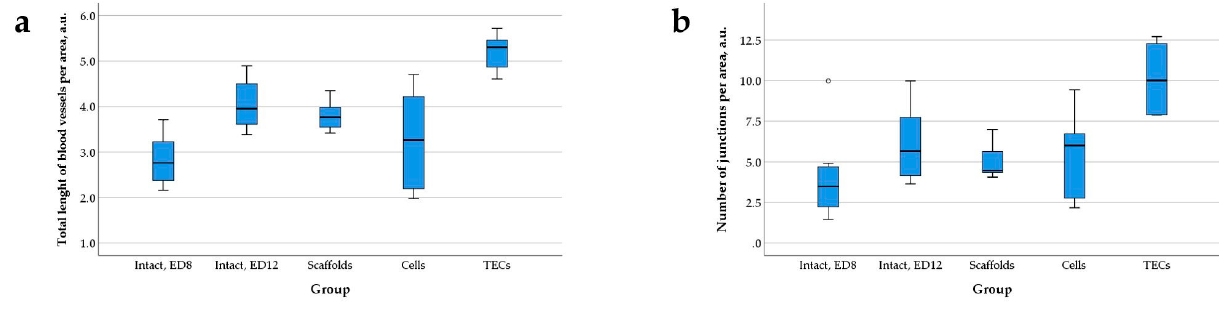
Figure A13. Cont